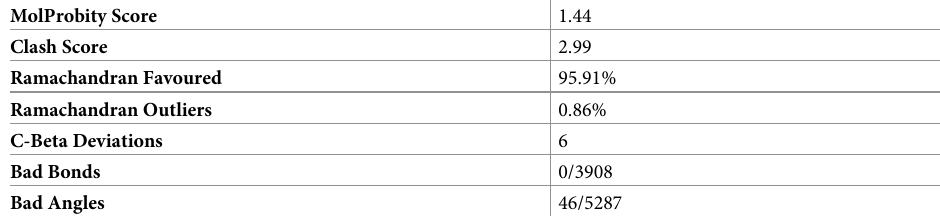
Table 3. MolProbity results to validate the SWISS-MODEL prediction for CYP11A1. A MolProbity Score close to 0 represents the resolution that one would see a structure of this quality. Clash score represents overlapping residues; a lower value is favored. Outliers represent values that extend outside the standard deviation; low values are also favored. Low values for bad bonds and angles are also